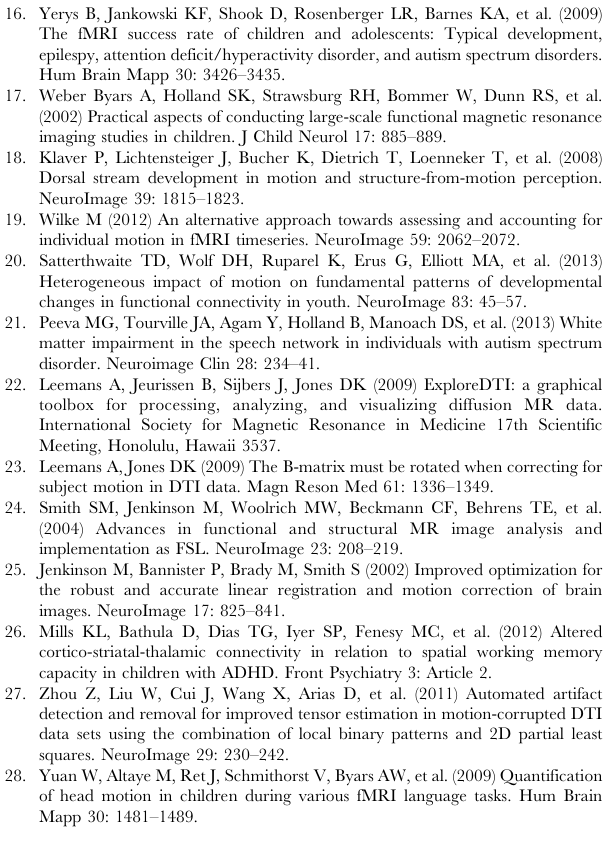
Table S3 Demographics and motion parameters for the 71 children undergoing rfMRI